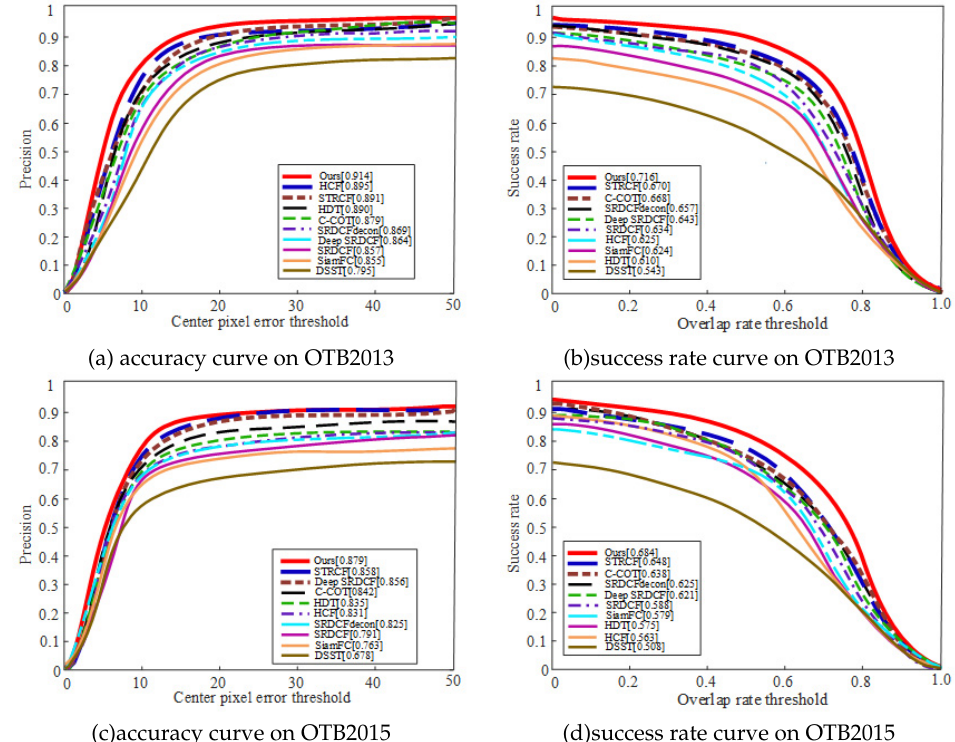
Fig. 2. Comparison curve of distance accuracy and success rate on the OTB2013 and OTB2015